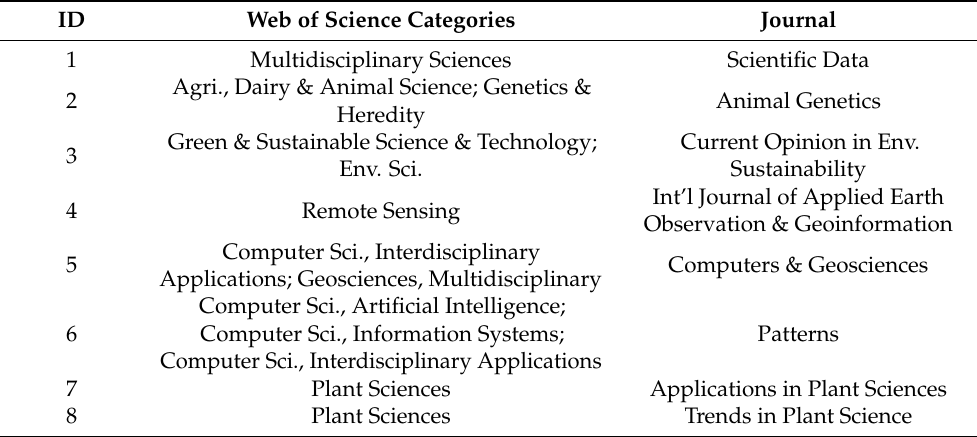
Table 3. Web of science categories and journals included.